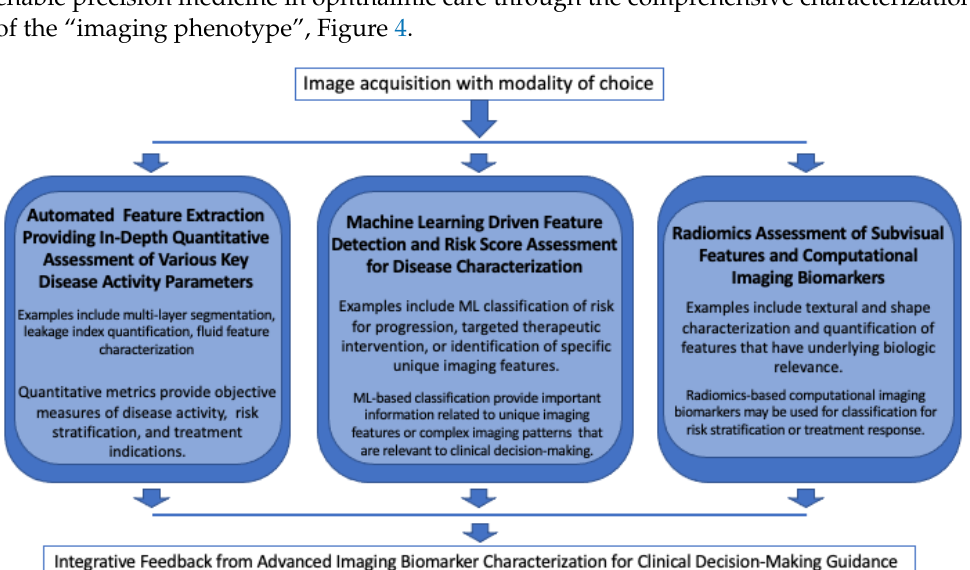
Figure 4. Developing the “Imaging Phenotype”. A potential multi-factorial approach for integrative imaging biomarker characterization utilizing multiple advanced feature interrogation and extraction methods.